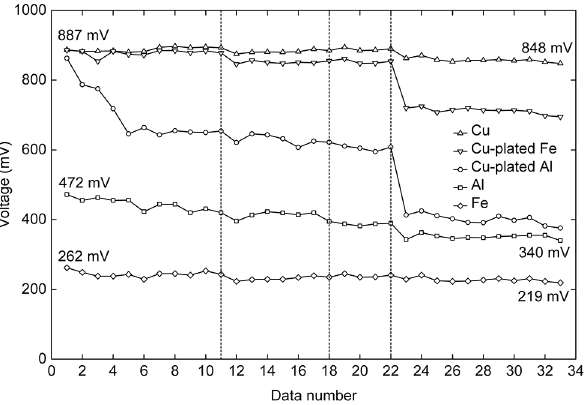
Fig 5. Voltage variations in the primary experiment. Five curves display the voltage variations measured with the five different electrodes. All curves show an overall decreasing trend. The Cu electrode yields the highest measured voltage, followed by Al and Fe. The curve acquired from the Cu-plated Fe electrode is closest to that of the Cu electrode. The curve of the Cu-plated Al electrode declines